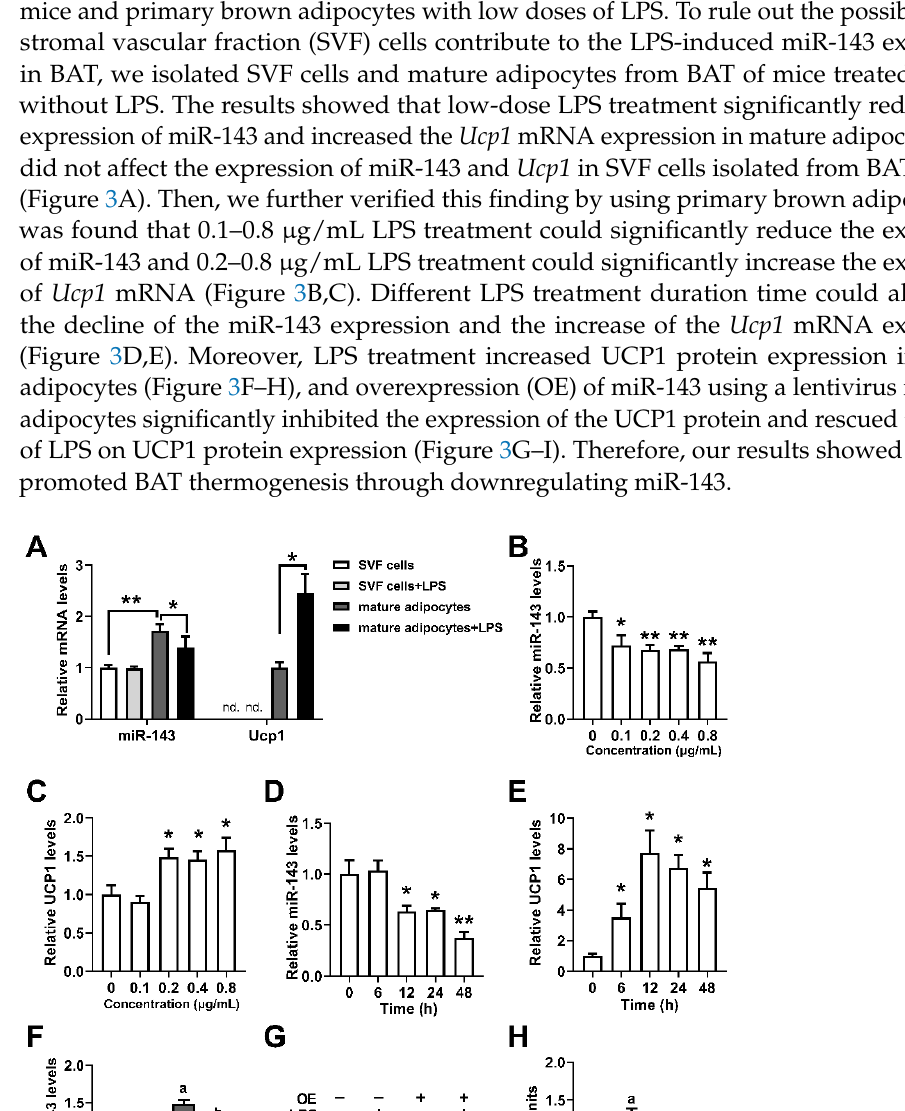
Figure 3. LPS increased UCP1 expression in brown adipocytes while downregulating miR-143. ( A ) The miR-143 and Ucp1 mRNA expression levels in the isolated SVF cells and mature adipocytes from BAT of mice treated with or without 10 µ g/kg LPS (n = 6); nd., not detected. ( B , C ) The miR-143 and Ucp1 mRNA expression in primary brown adipocytes in response to 24 h treat- ment with various concentrations of LPS (n = 6). ( D , E ) Time course of miR-143 and Ucp1 mRNA induc- tion in primary brown adipocytes in response to LPS (0.2 µ g/mL) treatment (n = 6). ( F – H ) The miR- 143 expression ( G ) and UCP1 protein levels ( H ) in WT and miR-143-overexpressed primary brown adipocytes treated with or without 0.2 µ g/mL LPS. Data are presented as the mean ± SEM. * p < 0.05 vs. controls; ** p < 0.01 vs. controls. Different letters above bars represent significant differences, with shared letters representing no significant differences, as determined by a two-tailed unpaired Student’s t -test ( A – F ) or two-way ANOVA followed by Tukey’s post hoc test ( G